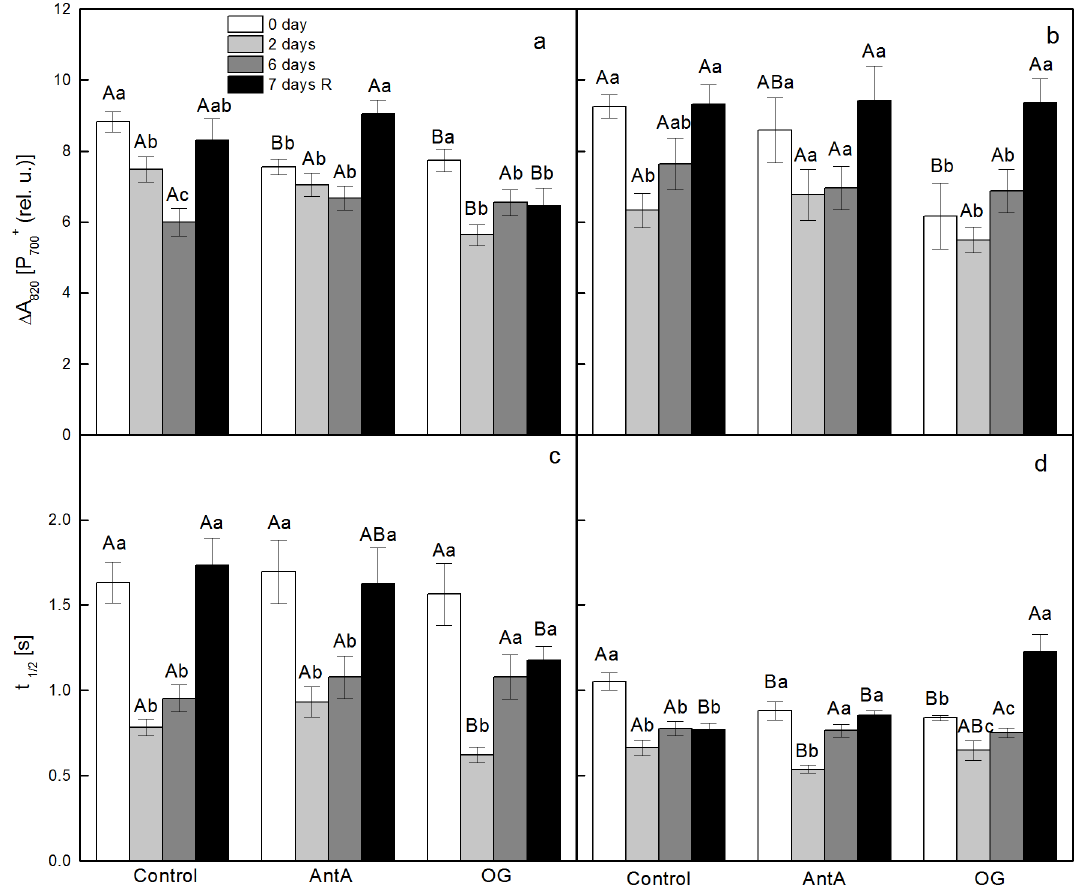
Figure 3. Alterations in far-red (FR) induced oxidation of reaction center of PSI (P 700 ) to (P 700 + ), as estimated by the absorbance change at 820 nm ( ∆ A 820 ) ( a , b ) and the capacity for cyclic electron transport through PSI (CEF), as assessed by determination of the half time (t 1/2 ) of the dark re- reduction of P 700+ after switching off the FR light ( c , d ). Leaf discs of Arabidopsis thaliana , wt ( a , c ) and lut2 ( b , d ), were floated for 2 h either on distilled water (Control) or on distilled water containing 10 µ M antimycin A (AntA) or 20 µ M octyl gallate (OG). Leaf discs were cut from non-treated plants (before start of every experiment, 0 day), after 2 or 6 days of treatment with low temperature and high light intensity or after a recovery period (7 days R). Results presented are mean values ± standard error (SE) from three parallel samples of two independent experiments ( n = 6). Different letters indicate significant differences for the respective parameters at p < 0.05 (uppercase for the different treatments (Control, AntA and OG) on a certain day; lowercase for the certain treatment at a different time periods (0 day, 2 days, 6 days and 7 days